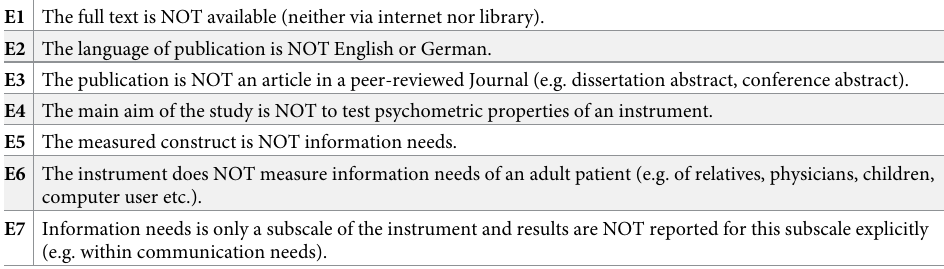
Table 2. Exclusion